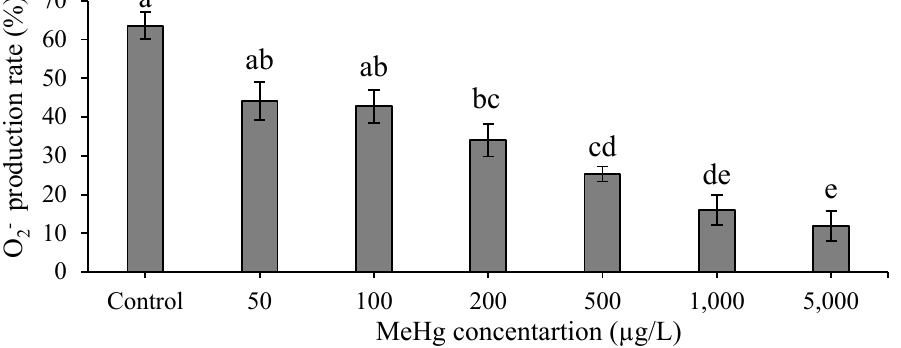
Figure 3. Superoxide anion production rate of hybrid grouper leukocytes after in vitro incubation with various concentrations of methylmercury for 30 min. One-way ANOVA and Tukey’ test were performed to compare the differences between groups. Values are presented as mean ± SD ( n = 3). Significant differences ( p < 0.05) among treatment groups are indicated by different letters above the bars.